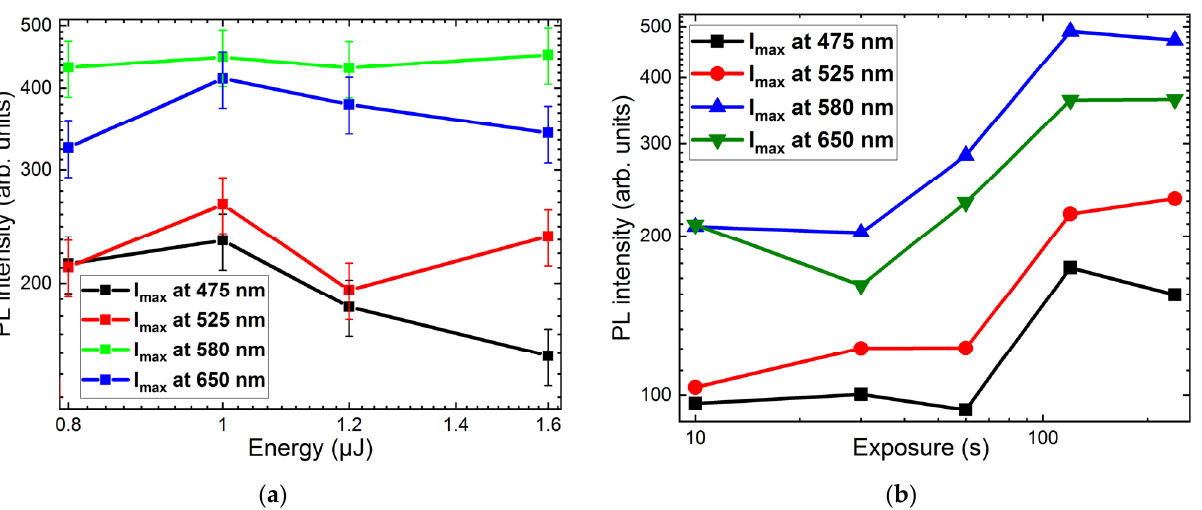
Figure 10. ( a ) Peak intensity in the micromark at different energies and ( b ) maximum of PL intensity spectra acquired in the micromark at 475, 525, 580 and 650 nm at different laser exposures (405 nm, 1–24 M pulses, pulse energy—1.6 µJ).